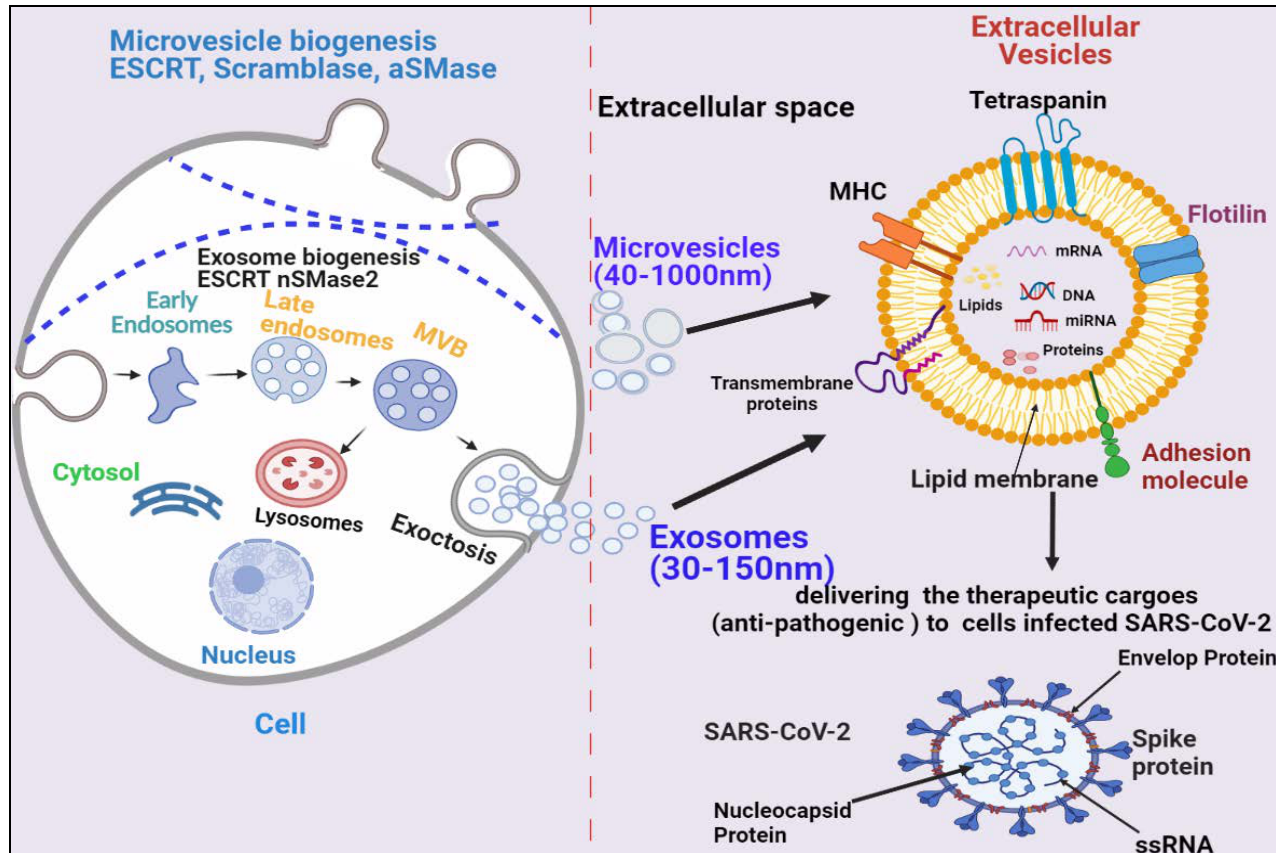
Figure 1. Biogenesis and secretion of EVs (microvesicles and exosomes) and their therapeutic role in COVID-19. The secretion of exosomes into the extracellular environmentundergoes three distinct steps: exosome biogenesis, intracellular trafficking of MVBs, and fusion of MVBs with the plasma membrane. Microvesicles are synthesized through direct outward budding and detachment of the plasma membrane into the extracellular milieu. Several molecules are involved in the biogenesis of both microvesicles and exosomes (small GTPases, ESCRTs, ARRDC1, syndecan, ceramide, tetraspanins). These EVs binds to SARS-COV-2-infected cells and deliver their therapeutic cargos to inhibit their pathogenesis.